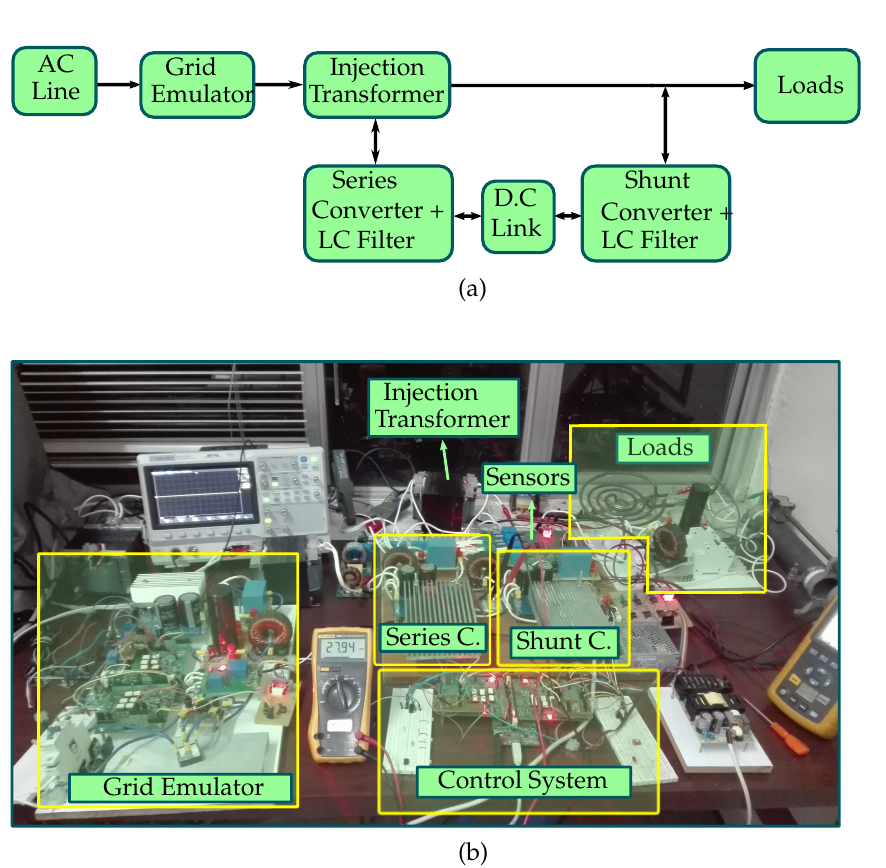
Figure 7. Experimental setup for the UPQC. ( a ) Block diagram for the experimental setup stages. ( b ) Experimental setup in the